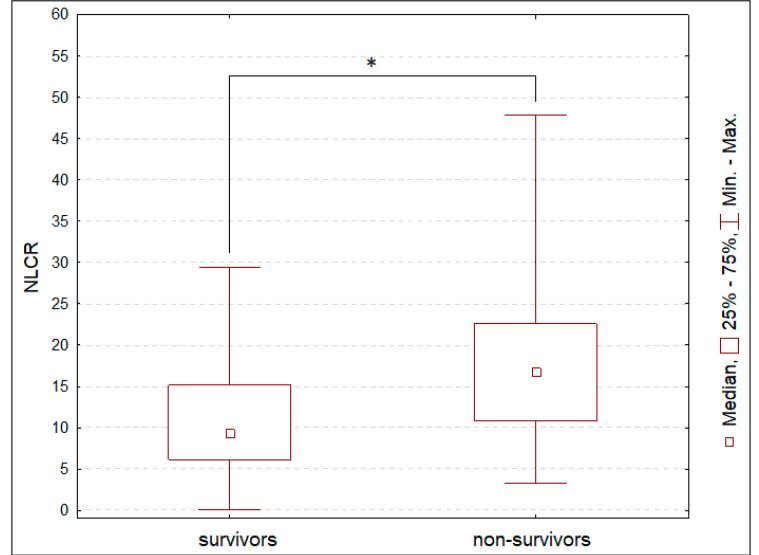
Figure 1. Neutrophil-to-lymphocyte count ratio (NLCR) in relation to different types of traumatic brain injury. *** p < 0.001 compared with baseline. DAI—diffuse axonal injury, CE—cerebral edema, ICH—intracerebral hemorrhage, S-EH/SAH—subarachnoid hemorrhage, epidural and/or subdural hematoma.